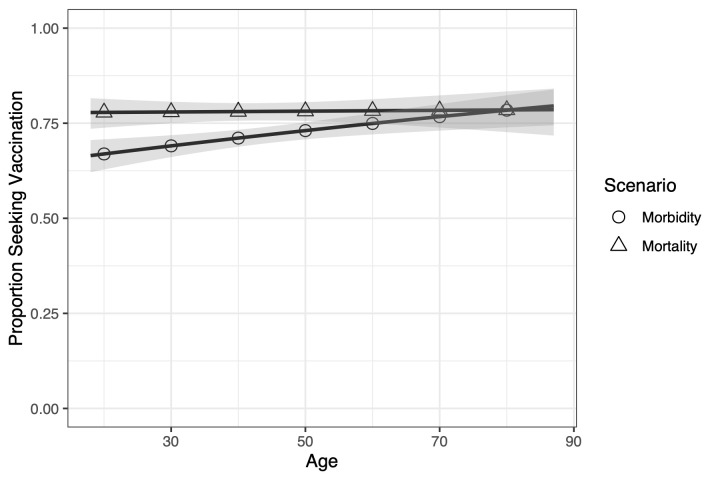
Comparing the morbidity and mortality scenarios across ages.The mortality scenario is relatively stable across ages, while the morbidity scenario changes. Younger populations are less motivated by morbidity than mortality, but older populations respond similarly to both scenarios. The solid lines are the trend lines, and the shaded area is the 95% prediction interval.